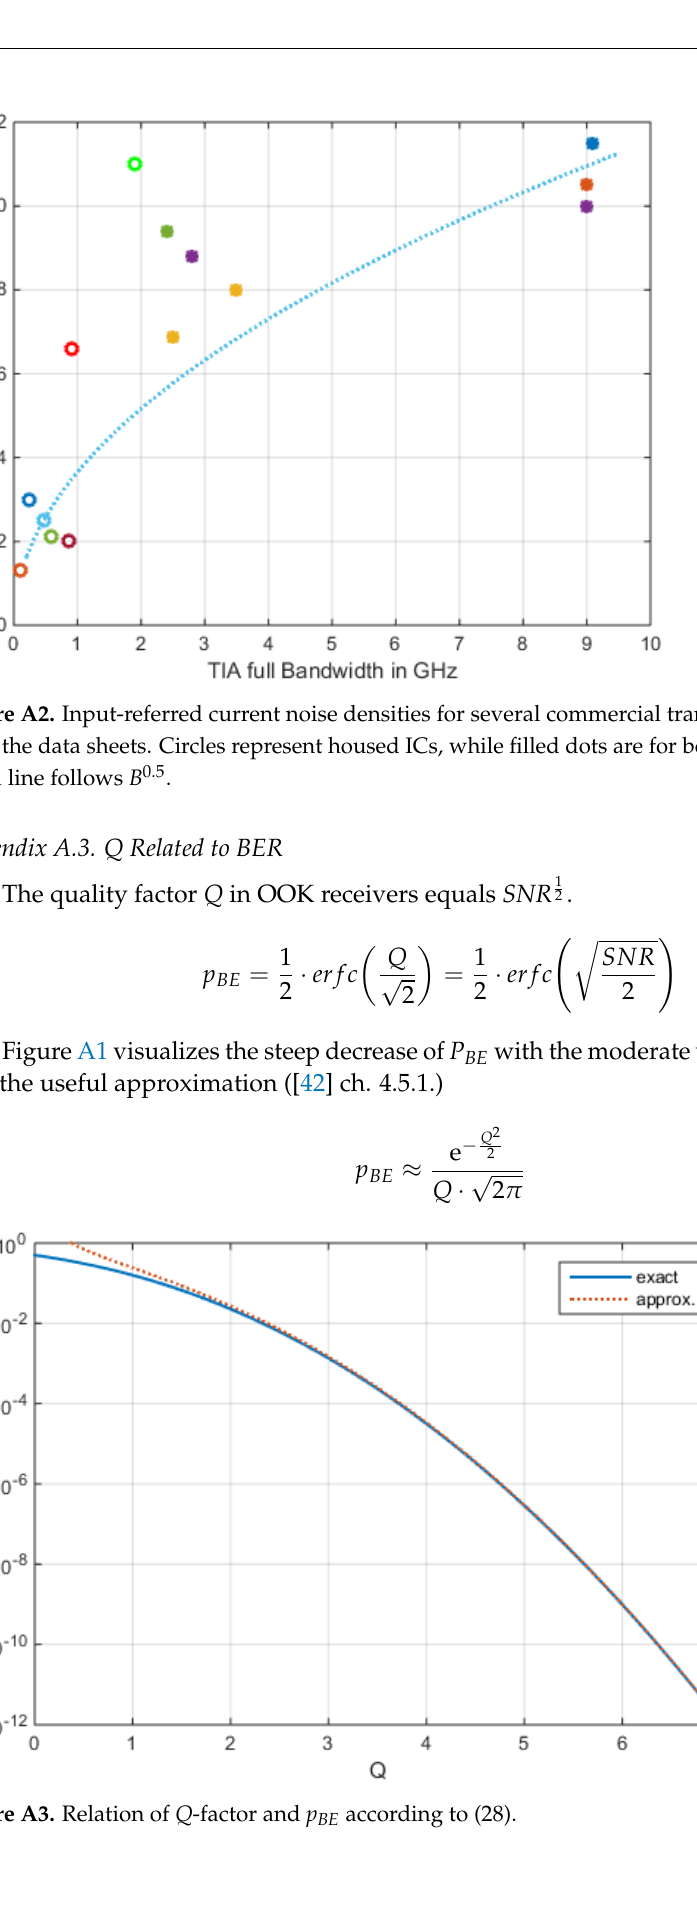
Figure A3. Relation of Q -factor and p BE according to (28).